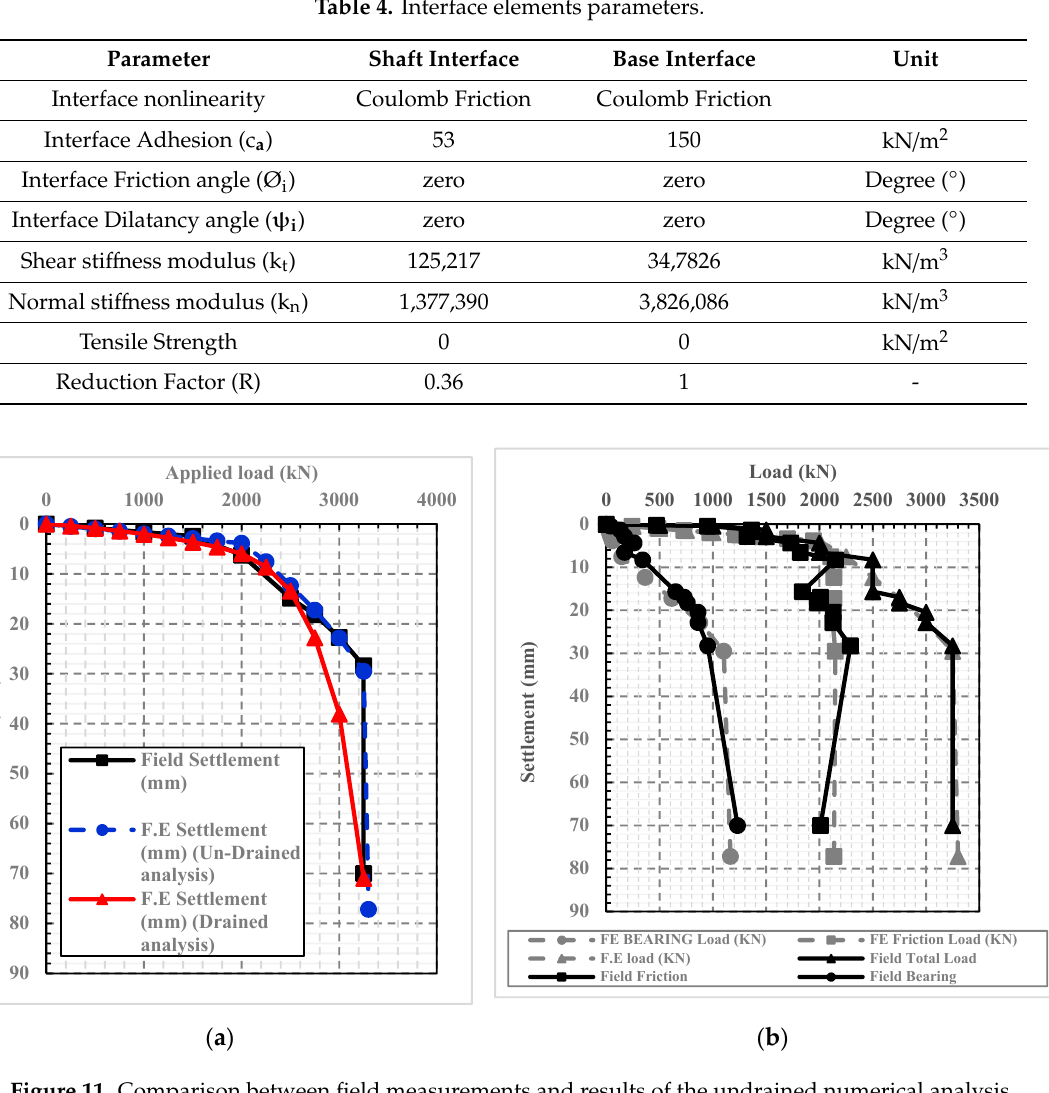
Table 4. Interface elements parameters .